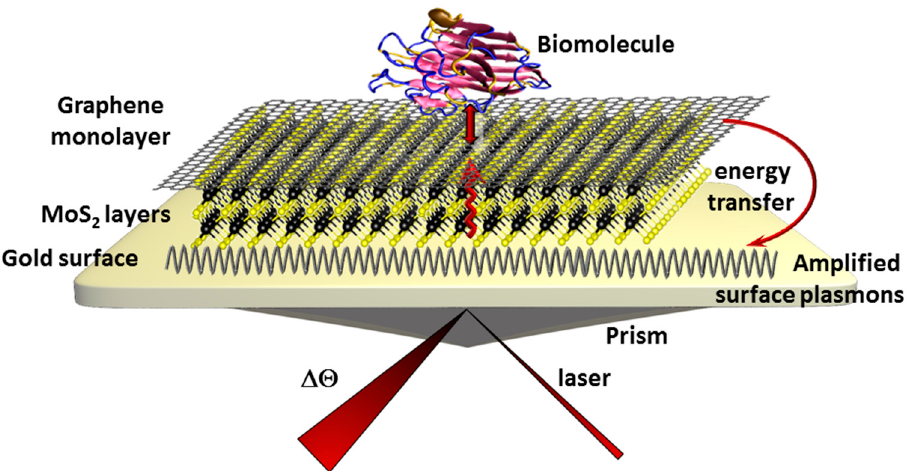
Figure 5. Principle of improved SPR signals after adsorption of a biomolecules using MoS 2 as intermittent layer between monolayer graphene and the gold surface.